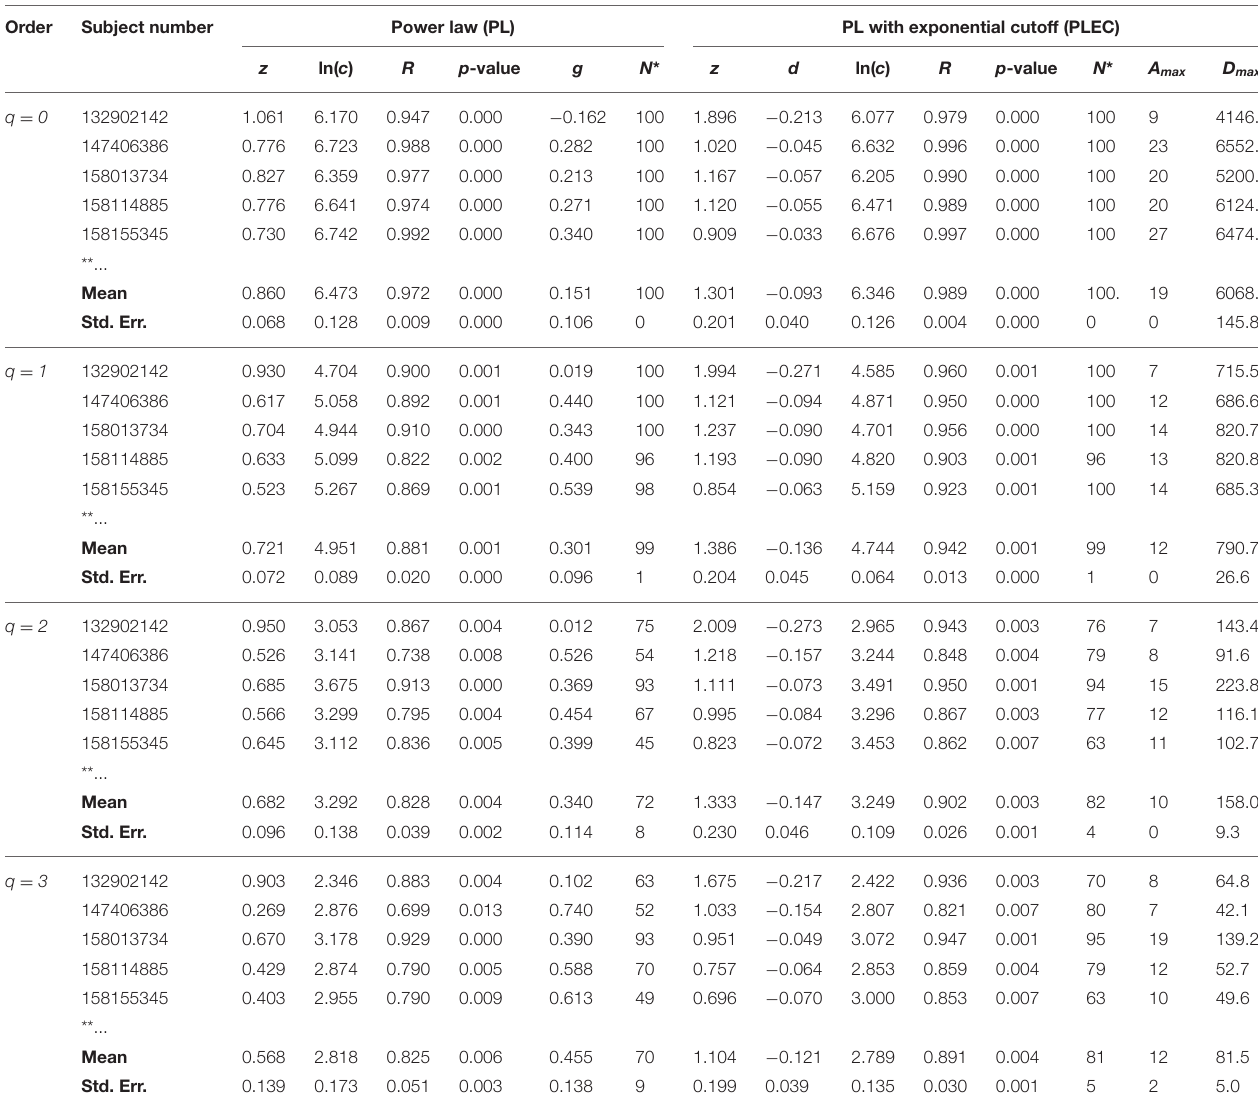
TABLE 1 | The intra-individual alpha-DAR modeling for the HMP dataset (Demon version, Full version in Table S1 ).